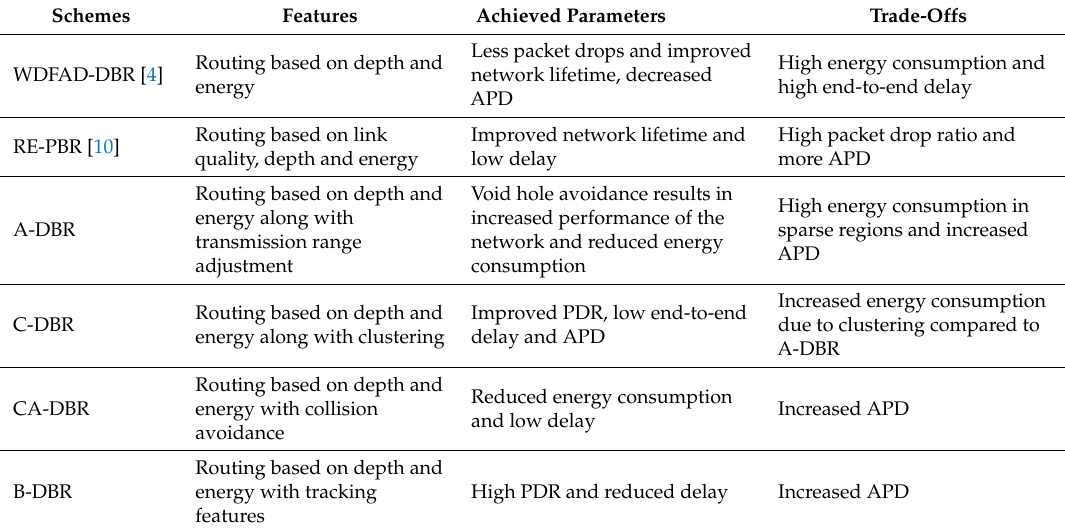
Table 4. Performance